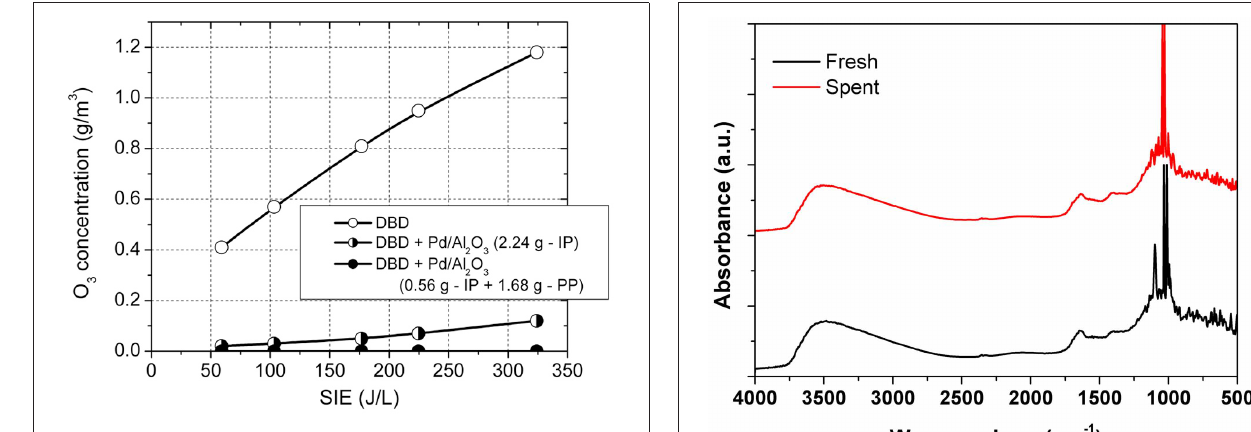
FIGURE 5 | Concentration of ozone in DBD and in the plasma catalytic system.